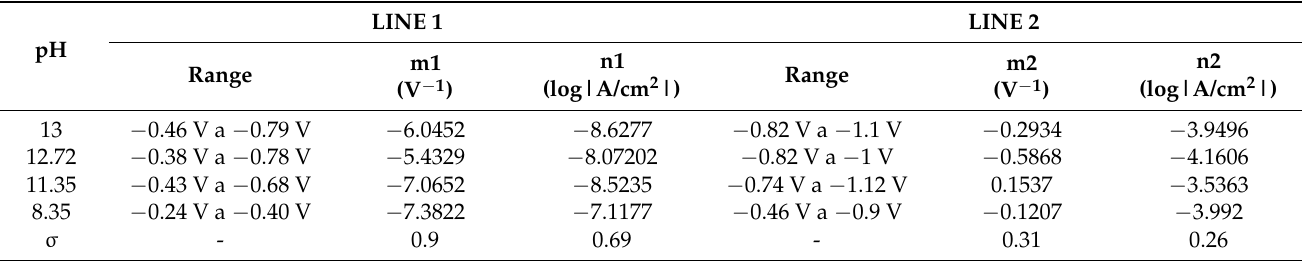
Table 6. This table summarizes data for the lines related to the O 2 availability and H 2 O results shown in Figure